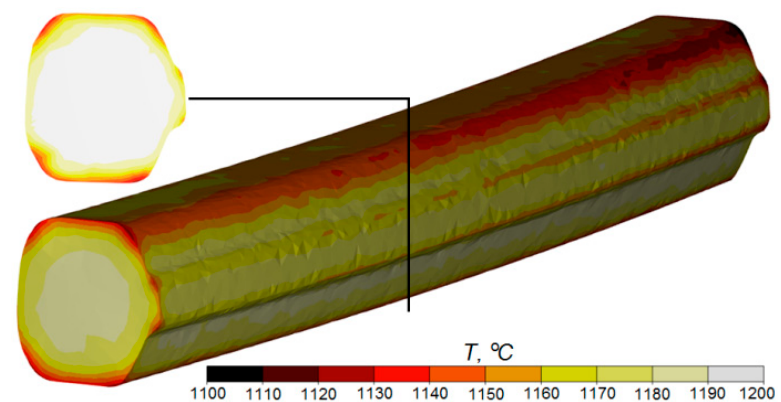
Figure 7. FEM temperature distribution in the blank longitudinally rolled in the groove pass.